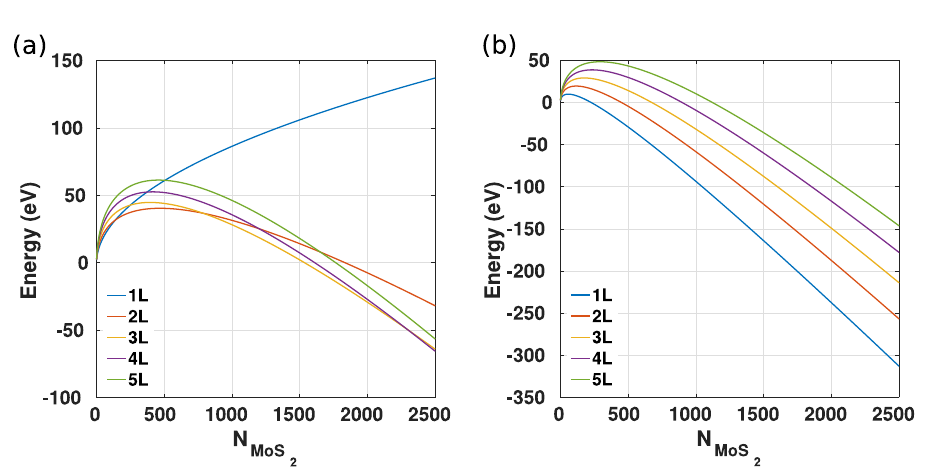
Figure 7. ( a ) The reproduction of Fig. 3(b) in ref. 55: the energy of isolated triangular flakes consisting of 1–5 layers (L) as a function of the number of MoS 2 units. The curves intersect with each other. As a result, as the cluster size ( ) N increases, the layer number of the expected stable configuration also increases. Reproduced MoS 2 from the ref. 55 with permission from the Royal Society of Chemistry. ( b ) The result of the augmented model that includes the stabilizing effect of the substrate. As a result, the curves no longer intersect apart from the origin, and monolayer is always thermodynamically preferable with